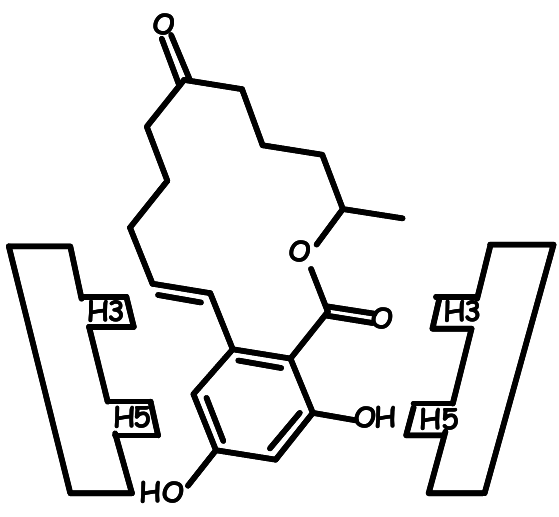
Figure 5. β -CD-zearalenone complex model from NMR